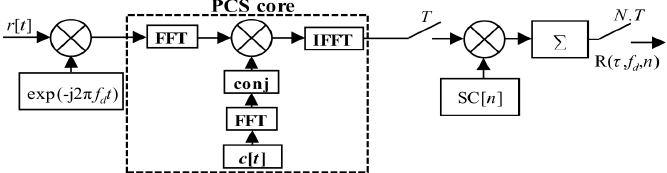
Figure 3. Acquisition schema using PCS, the straightforward single-step post-correlation approach .